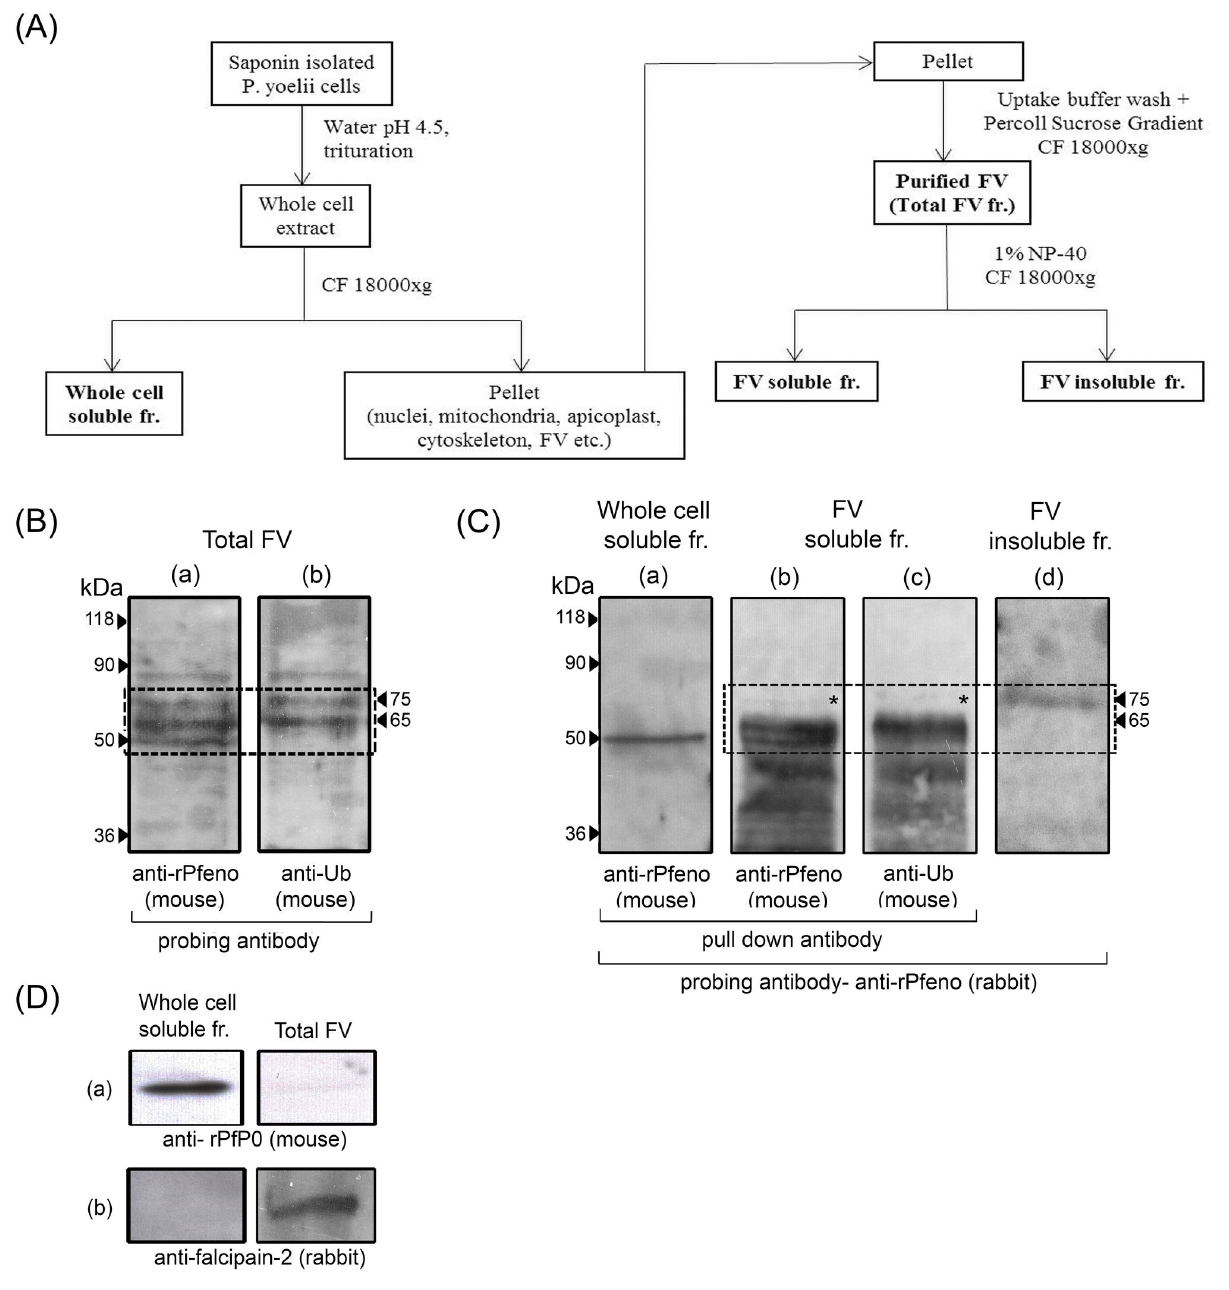
Figure 1. Analysis of P. yoelii food vacuole (FV) associated enolase variants using antibody pull down assays and western blots. (A) P. yoelii cell fractionation scheme. Various fractions used for analysis are marked in bold. Proteins were separated on 10% SDS